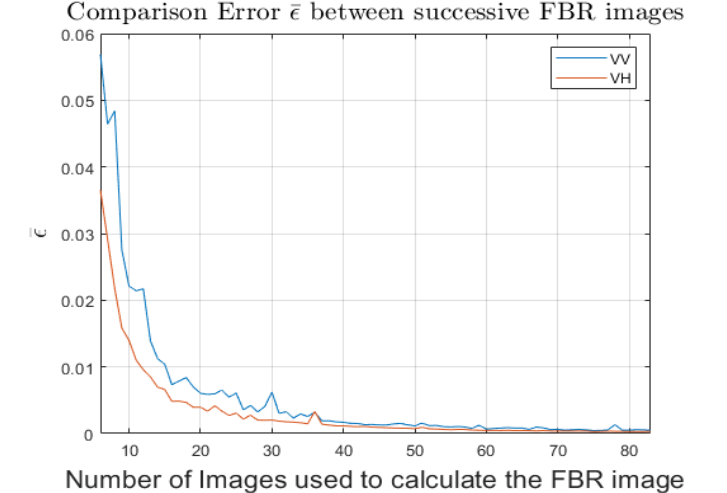
Figure 16. Mean error ¯ (cid:101) depending on the number of images used to compute the FBR